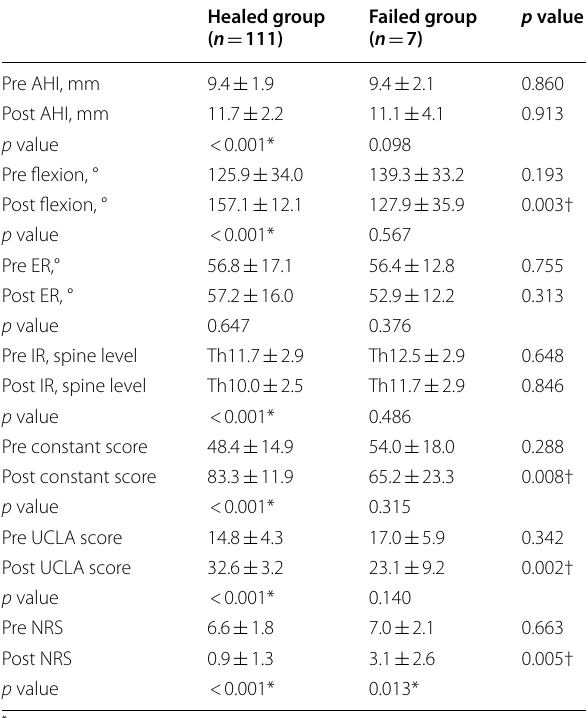
* Statistically significant between the pre- and post-operative values ( p < 0.05) † Statistically significant between the healed and failed groups ( p <